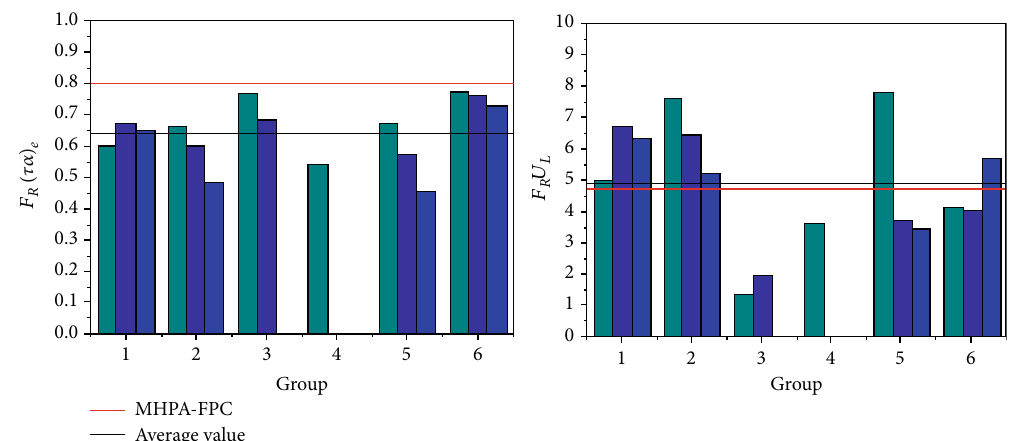
Figure 5: Comparison between MHPA-FPC and samples